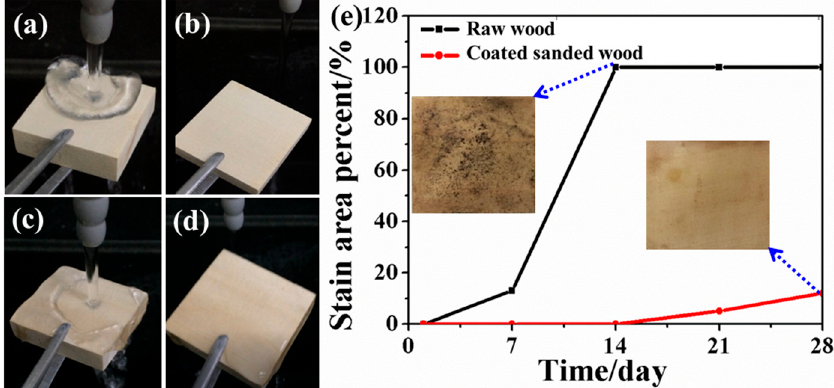
Figure 7. Photographs of the superhydrophobic wood surface ( a ) during water washing and ( b ) after water washing. Photographs of the raw wood surface ( c ) during water washing and ( d ) after water washing. ( e ) Comparison of mildew infection on the surface of raw wood and coated sanded wood in a humid environment.